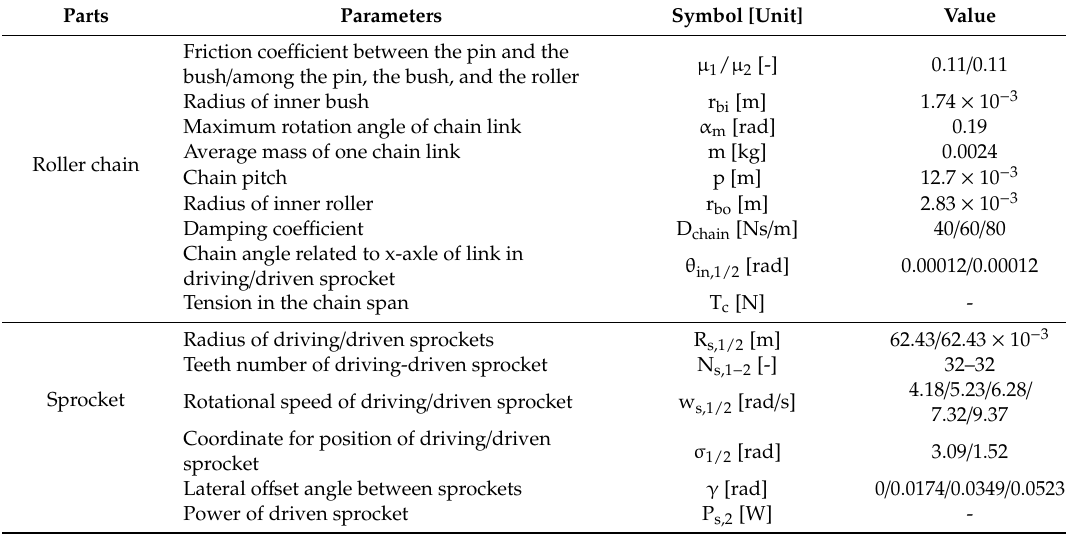
Table 1. Drive train components and parameters for roller chain